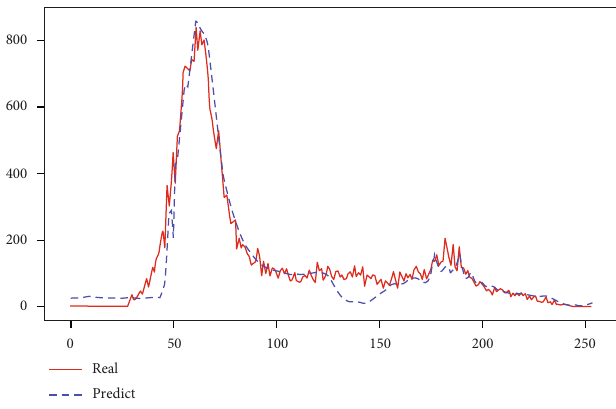
Figure 10: Prediction results of Pingguoyuan Station of Metro Line 1 on August 29,